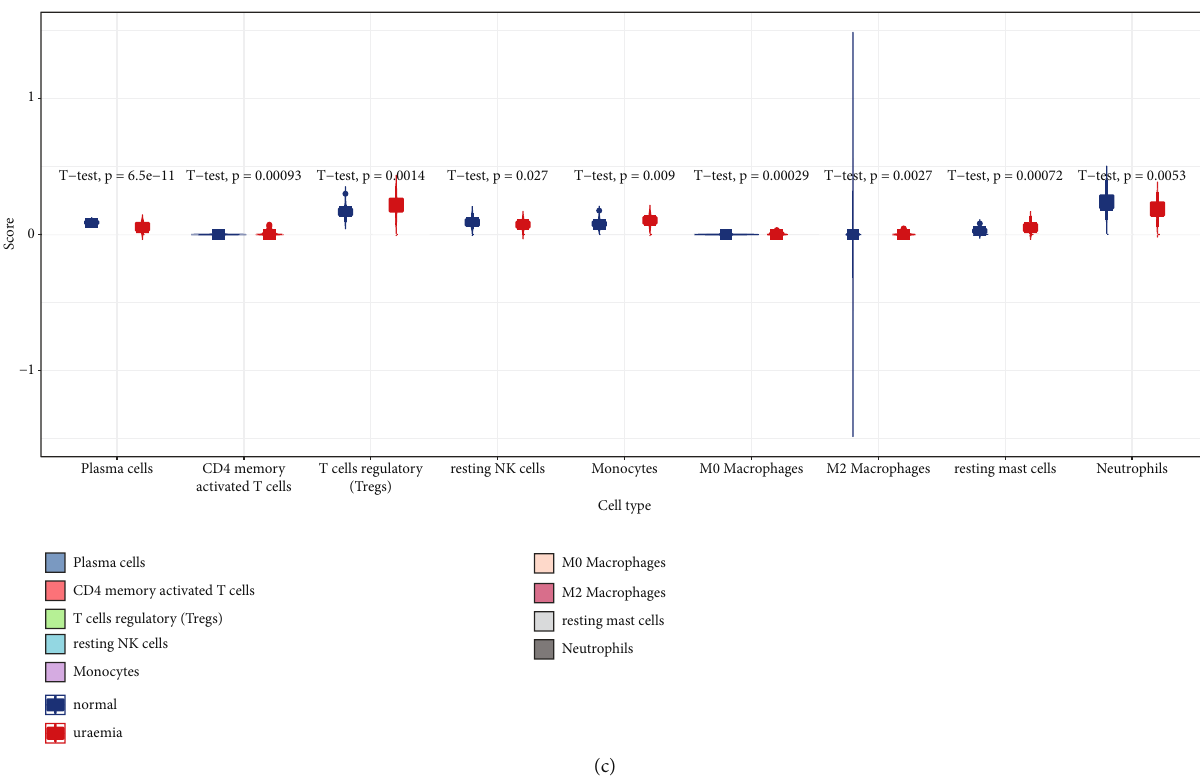
Figure 4: Immune-related genes. (a) Venn diagram for the overlapping comparison of immune-related genes and DEGs. (b) Immune in fi ltration. (c) Nine types of immune cells with signi fi cant di ff erences in normal and uremic